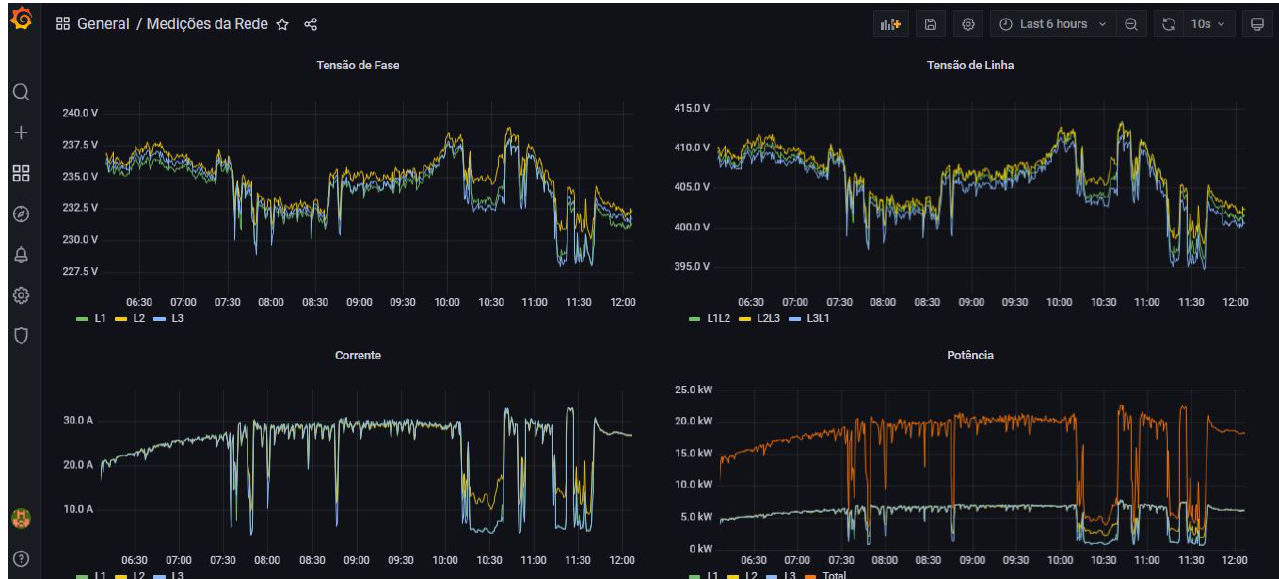
Figure 18. AC-Grid measurements for the solar power